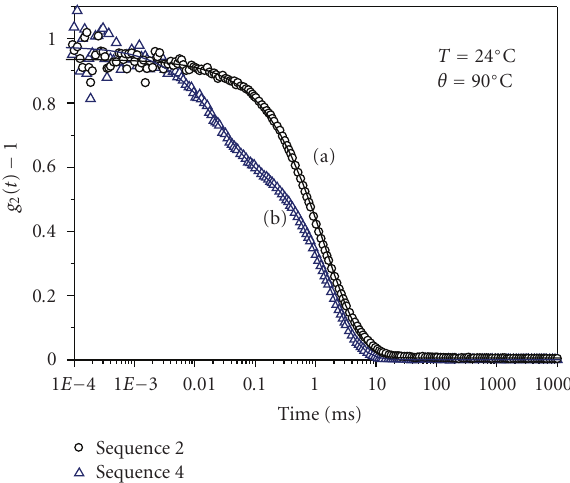
Figure 3: Typical autocorrelation functions of short (a) and long (b) oligonucleotide solutions prepared by dialysis method ( c = 0 . 4mM).